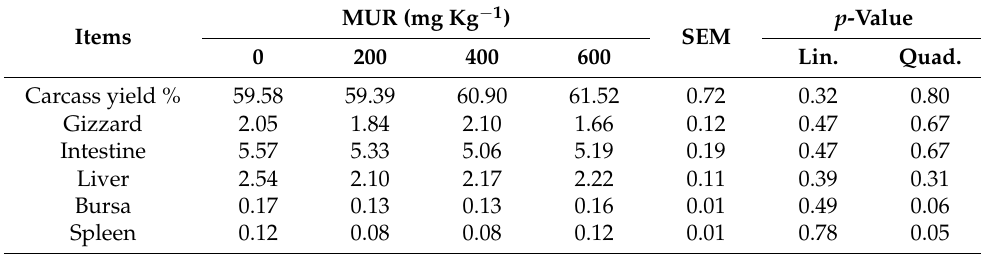
Table 4. The effect of MUR on the carcass characteristics relative to the live Wt. (%).